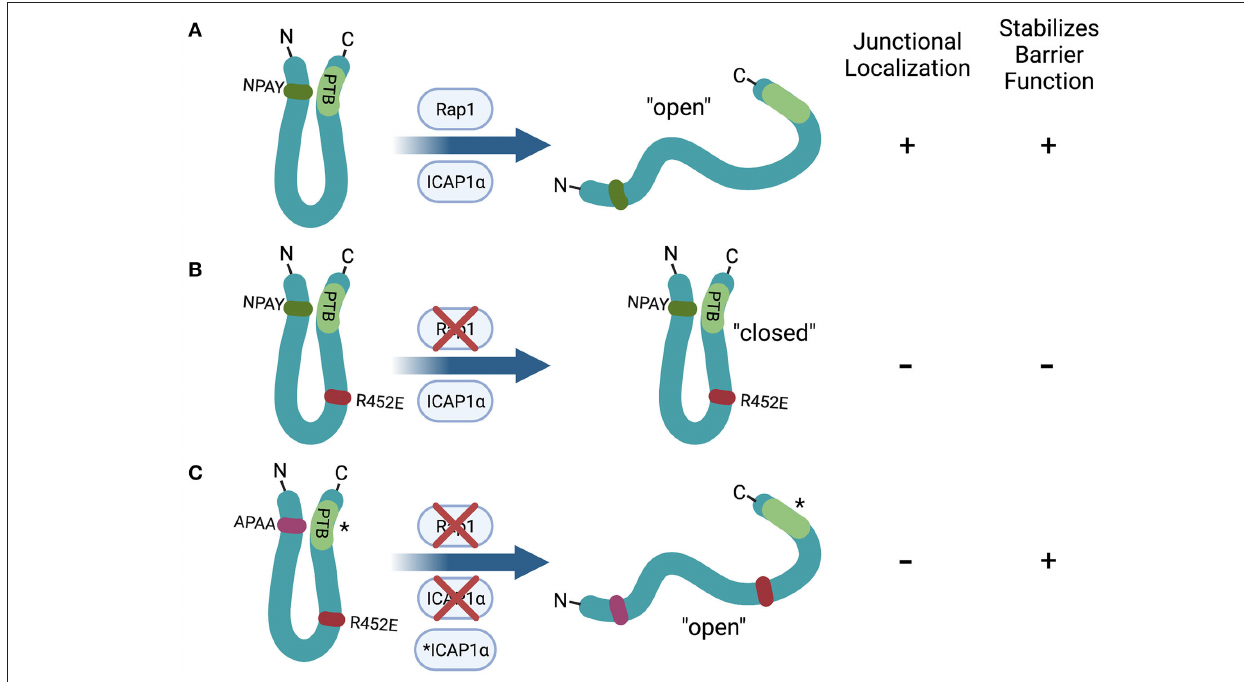
FIGURE 3 | Hypothetical role of the N- to C- terminal self-interaction of KRIT1 in the regulation of barrier function. (A) Rap1 or ICAP1 α binding to wildtype KRIT1 inhibits the N- to C-terminal interaction, leading to enhanced junctional localization (due to Rap1 binding) and stabilization of endothelial cell-cell contacts. (B) Mutation of the Rap1 binding interface (R452E) ablates junctional localization and barrier stabilization, likely due to a reduction in the proportion of the “open” conformation. (C) KRIT1 containing mutations in both the Rap1 binding interface (R452E) and the first NPXY motif (APAA) stabilizes cell junctions even though it remains cytoplasmic. Mutation of the PTB domain (*) has the same effect as mutating the NPXY motif, indicating that ICAP1 α binding is not required for this effect. Created with